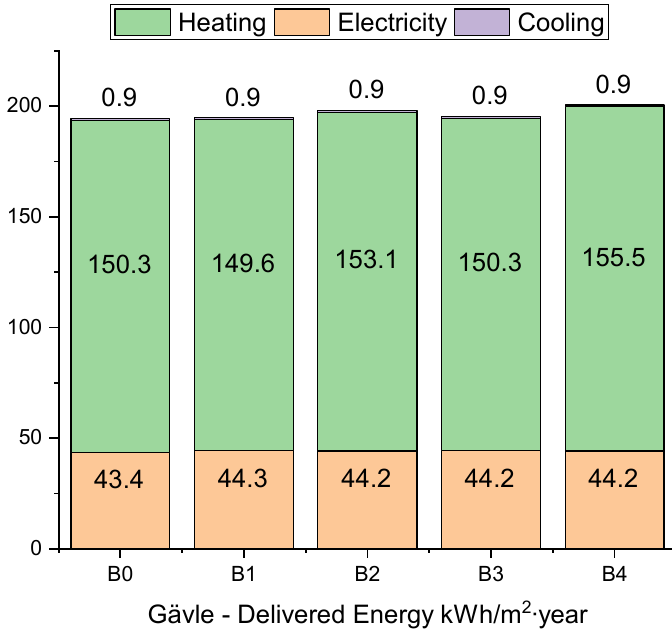
Figure 9. Gävle—Delivered energy profile for B0–B4.